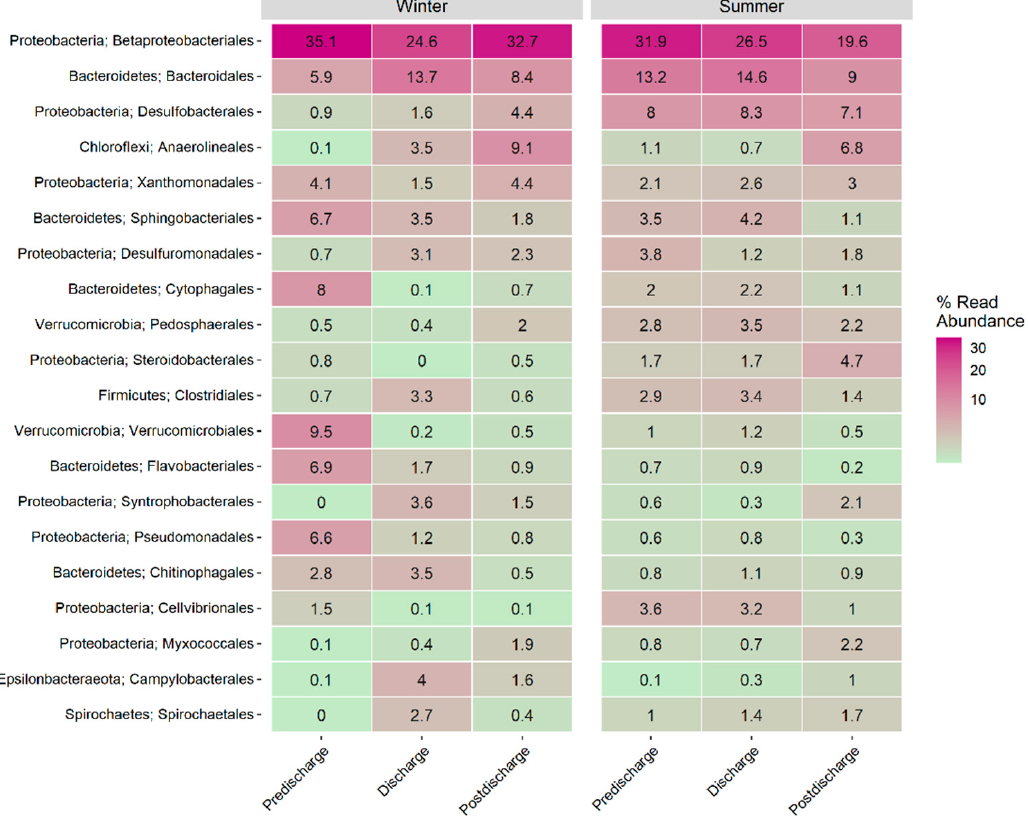
Figure 8. Heatmap showed the most dominant orders in the pre-discharge, discharge, and post- discharge stations during winter and summer.